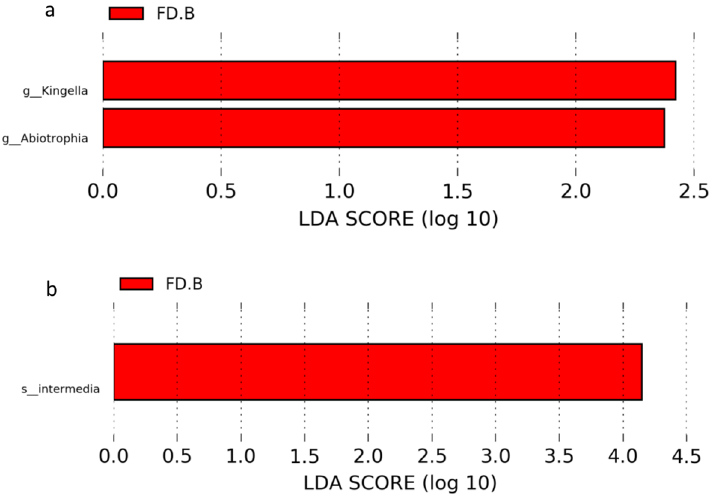
Figure 3. Saliva biomarkers to classify FD and HC groups. ( a ) Saliva genus level LEfSe analysis in FD and HC. ( b ) Saliva microbiota species-level microbiota biomarkers in FD and HC groups. Linear discriminant analysis